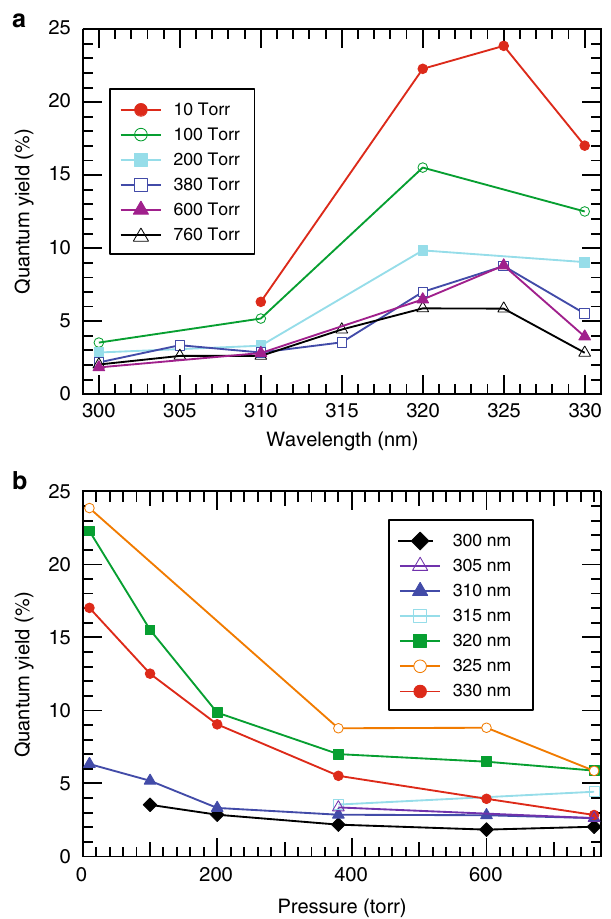
Fig. 3 Quantum yields of vinyl alcohol. Quantum yields for vinyl alcohol production as a function of a wavelength and b pressure at room temperature. Uncertainty ±25% of the stated